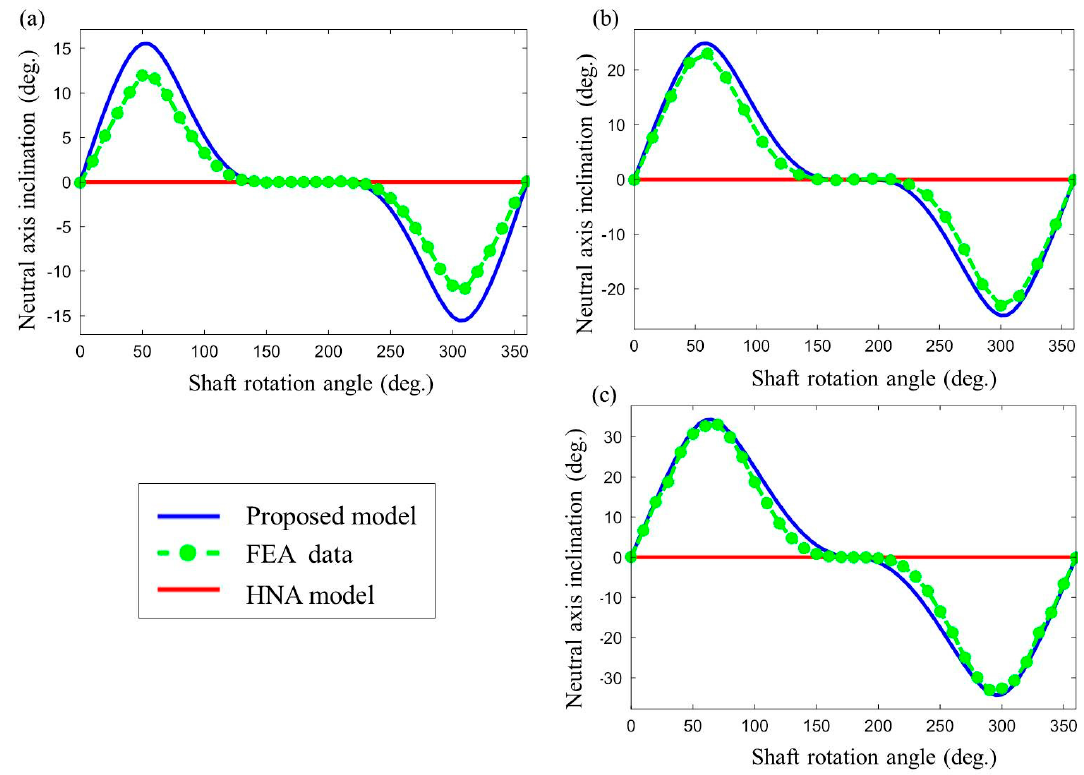
Figure 10. Variations in the inclination angle of the neutral axis as the cracked shaft rotates for chosen crack depths of ( a ) μ = 0.5, ( b ) μ = 0.7 and ( c ) μ = 1. R = 6.35 mm.